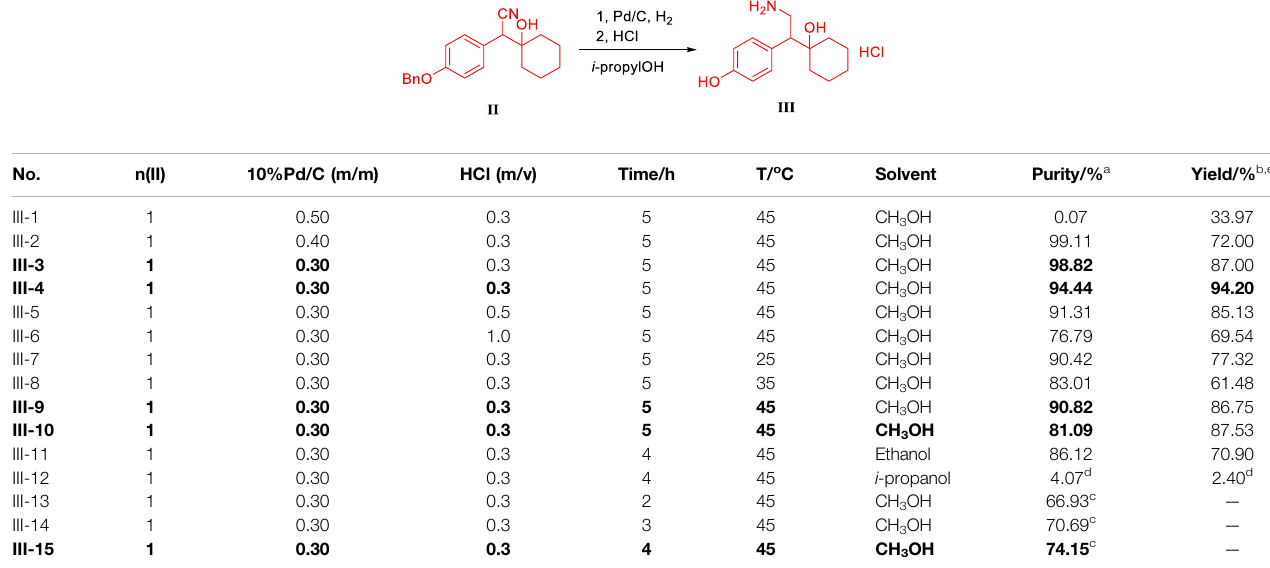
TABLE 3 | Condition optimization of Intermediate III.